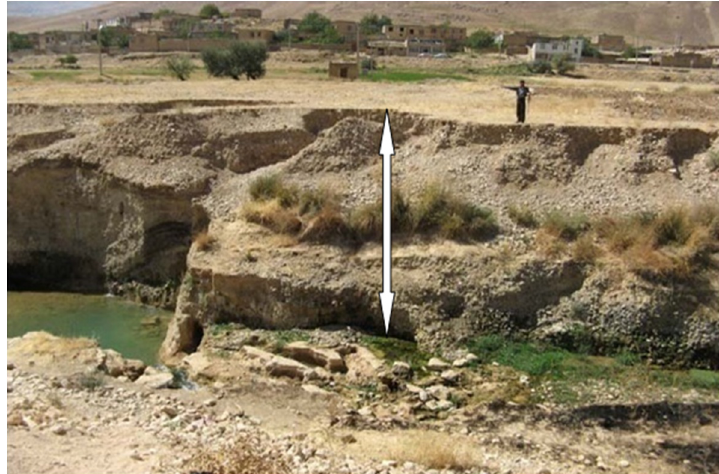
Figure 4. Channel incision in the Khoshkehroud River [65].